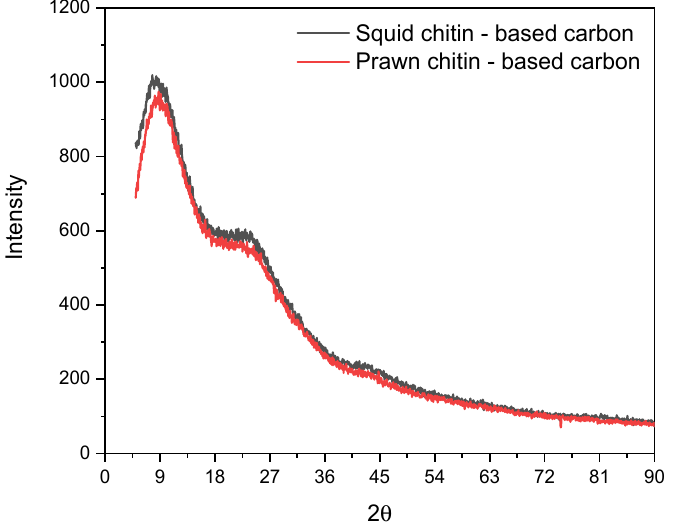
Figure 7. X-ray diffraction (XRD) patterns for squid (black) and prawn (red) chitins-based carbons. Both samples are amorphous and characterized by broad reflection peaks at around 8, 24, and 45°. The peaks associated with 2 θ = 24 and 44/45° correspond to the (002) and (100) planes of graphitic carbon, respectively [55,56]. The wide (002) diffraction pattern